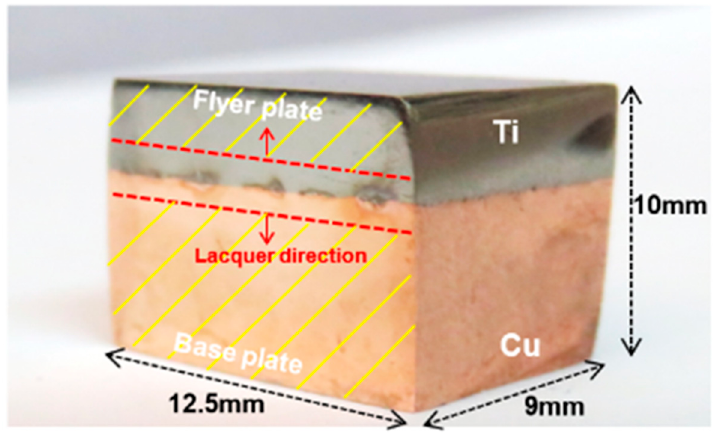
Figure 1. Photograph image of Ti-Cu bimetal sample for experimental measurements.